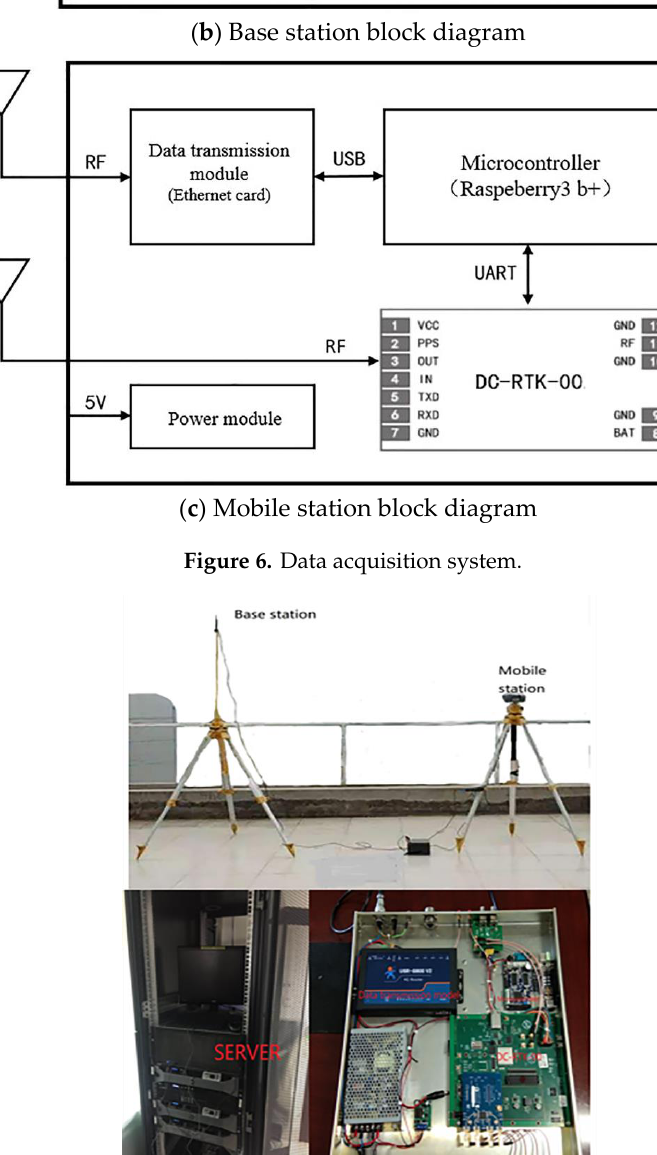
Figure 7. Scene map and physical device diagram.